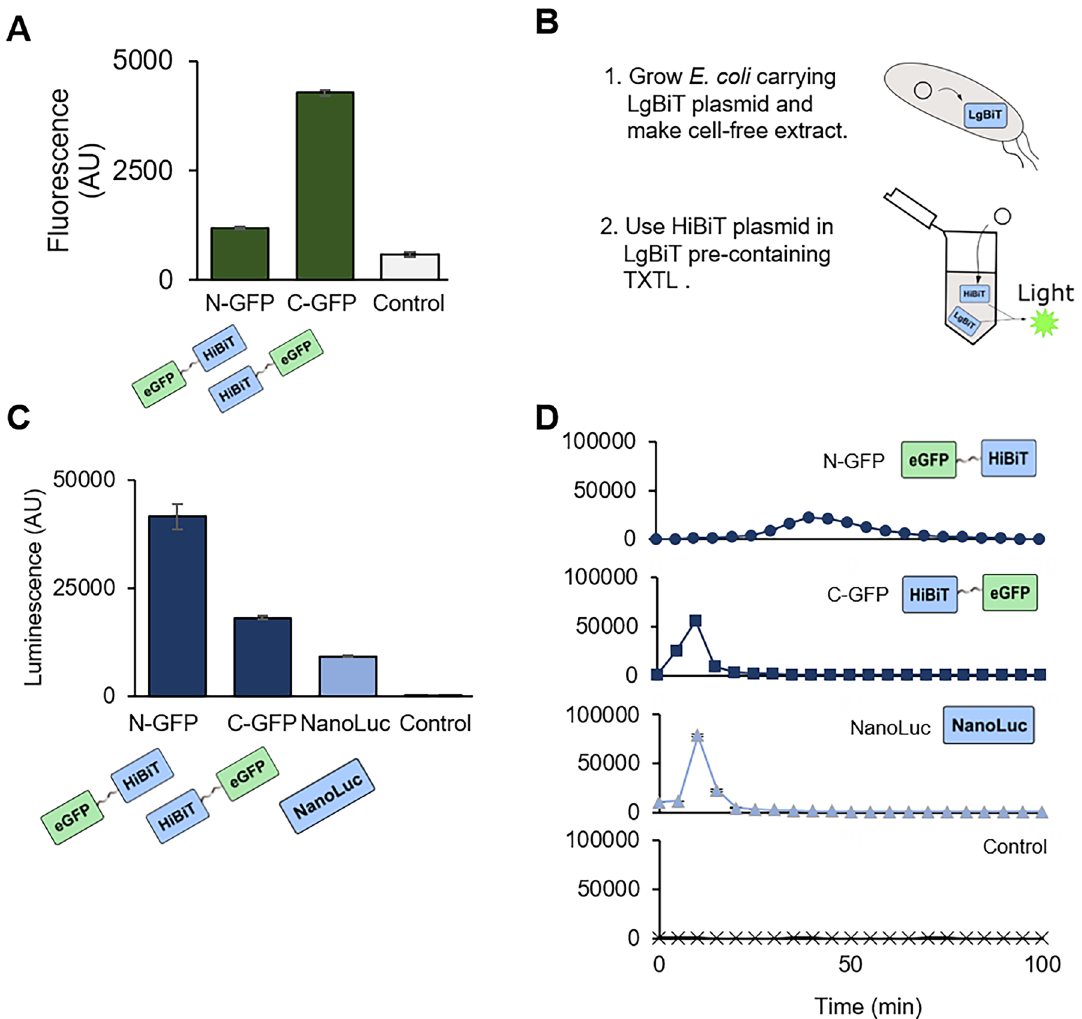
Figure 6. Demonstration of the use of HiBiT reporter system in TXTL. ( A ) eGFP fluorescence measurement of the HiBiT-GFP fusion proteins. Fusion proteins were expressed in TXTL at 30 °C for 8 h, followed by the fluorescence measurement. ( B ) The schematic of how LgBiT-carrying E. coli cell-free extract works. The plasmid coding LgBiT gene under the sigma 70 promoter is transformed into E. coli Rosetta 2 strain. The cell-free extract is made with that strain; thus, the extract contains LgBiT. Once HiBiT is expressed in TXTL, HiBiT produces luminescence by reconstituting a full luciferase with LgBiT. ( C ) End-point luminescence assay with the fusion HiBiTs. The fusion HiBiTs were expressed in the LgBiT-containing TXTL at 30 °C for 8 h. After the expression, 1 µM Furimazine was added, followed by luminescence measurement. ( D ) Luminescence kinetics measurement with the LgBiT-containing TXTL. HiBiT plasmids and Furimazine were added at the TXTL reaction set up and incubated at 30 °C. The luminescence was measured every 5 min during the TXTL reaction. N-GFP, N-terminal eGFP fusion with HiBiT; C-GFP, C-terminal eGFP fusion with HiBiT; Control, reaction without enzyme expression. The graphs show means with error bars that signify SEM (n =